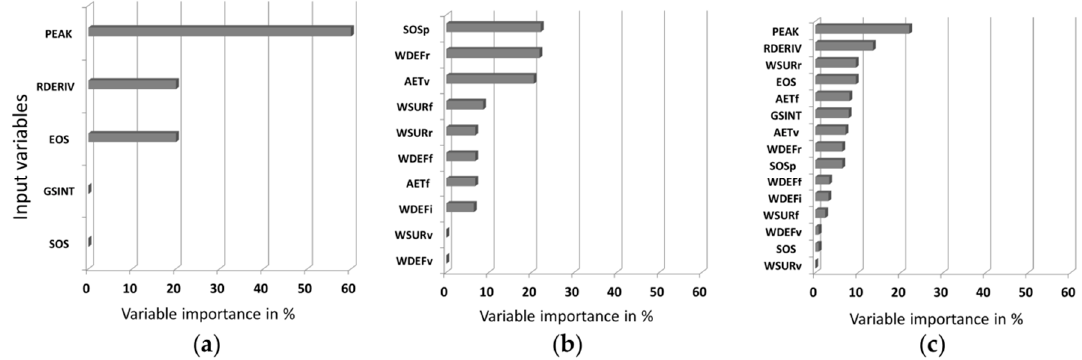
Figure 5. Importance of the predictor variables for the three herbaceous yield estimation models: ( a ) VI-model; ( b ) AGRO-model; ( c ) VIAGRO-model. Single variable importance initially given as the means of the percentage of use in model conditions and equations were then normalized to sum 100% for each model.